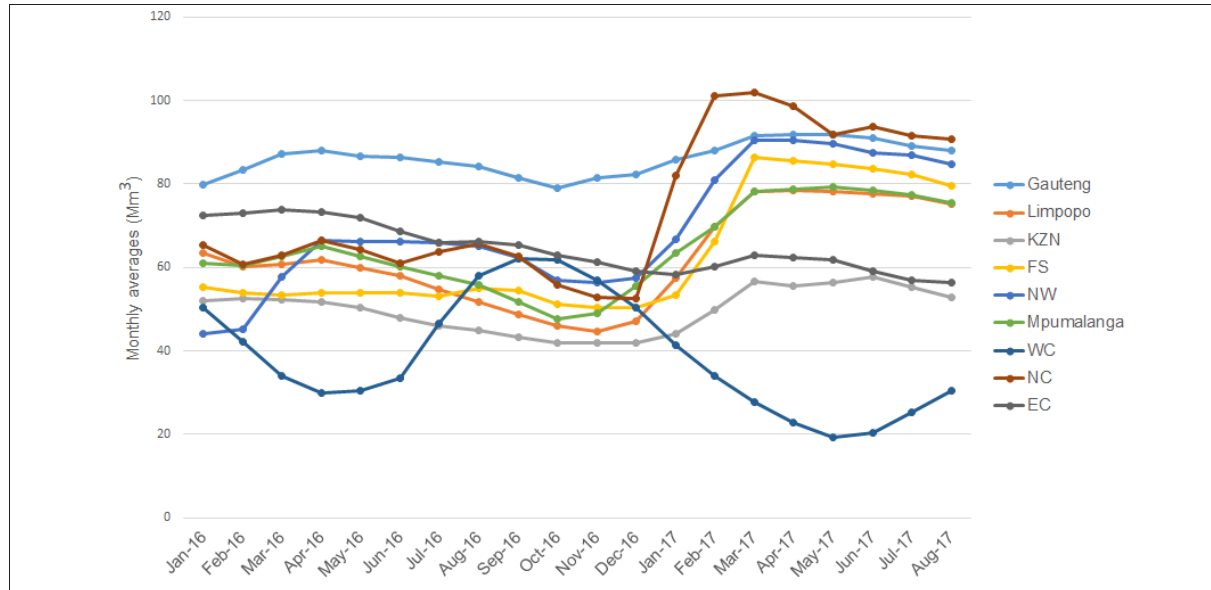
Figure 1 : Status of averaged dam levels from January 2016 to August 2017 at provincial